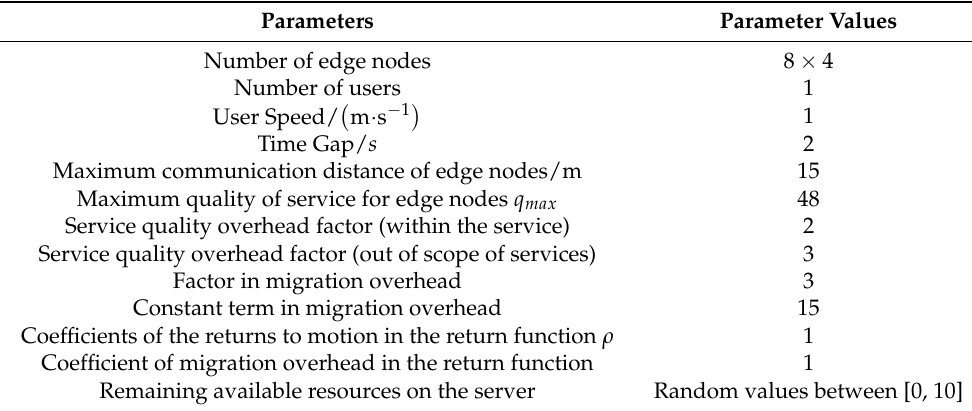
Table 2. Simulation experiment parameter settings. Parameters Parameter Values